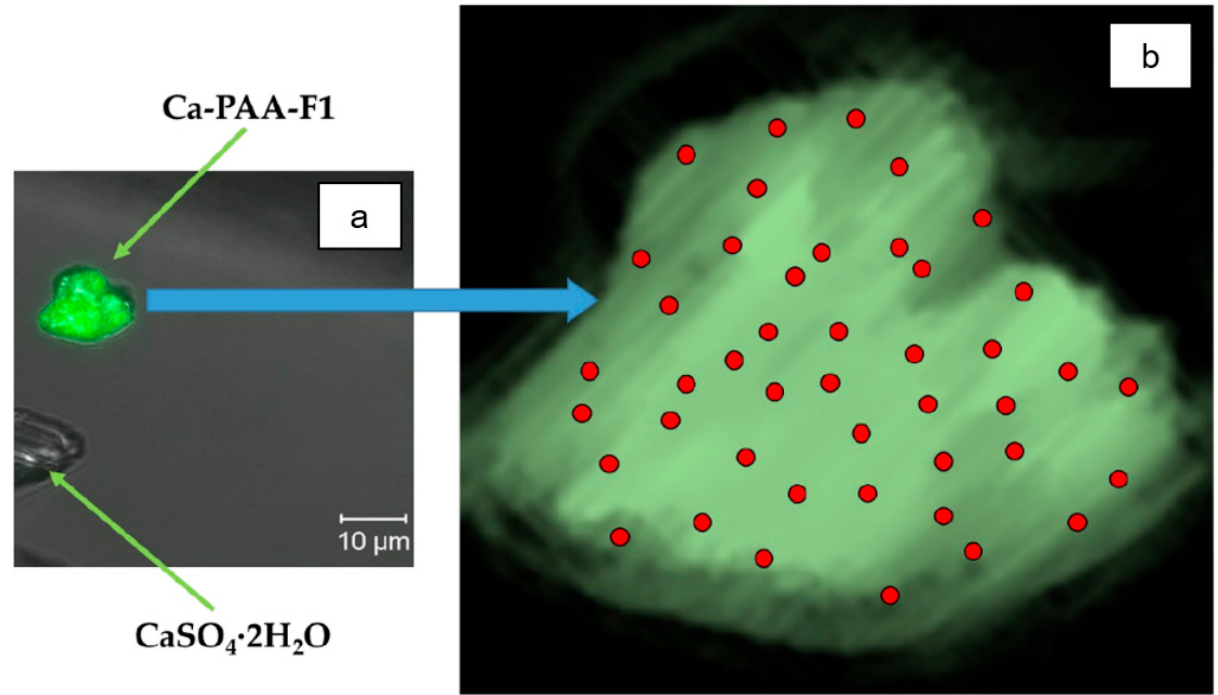
Figure 9. Two-dimensional fluorescence image of CaSO 4 · 2H 2 O and Ca-PAA-F1 solids in the Ia experiment ( a ), and the proposed scheme of foreign nanoimpurities (indicated by red circles) accumulation by Ca-PAA-F1 particles ( b ).